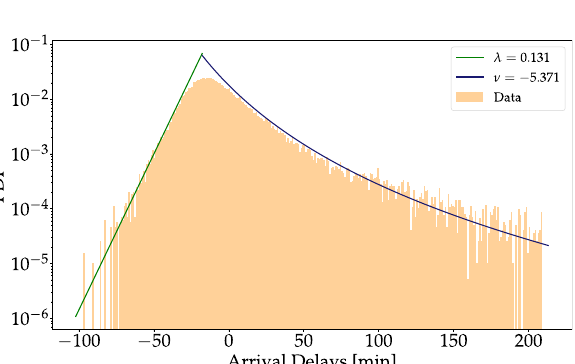
Figure 3. Exponential (green) and q -exponential (blue) theoretical distributions capture the empirical distribution. The fits are obtained via the MLE method, see “Methods” for fitting details. To complement the over-estimated “peak” (tent-like shape) we introduce the mean delay µ